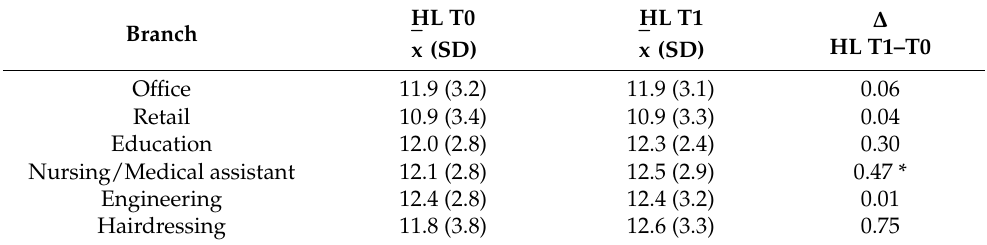
Table 4. Changes in health literacy over time in the different